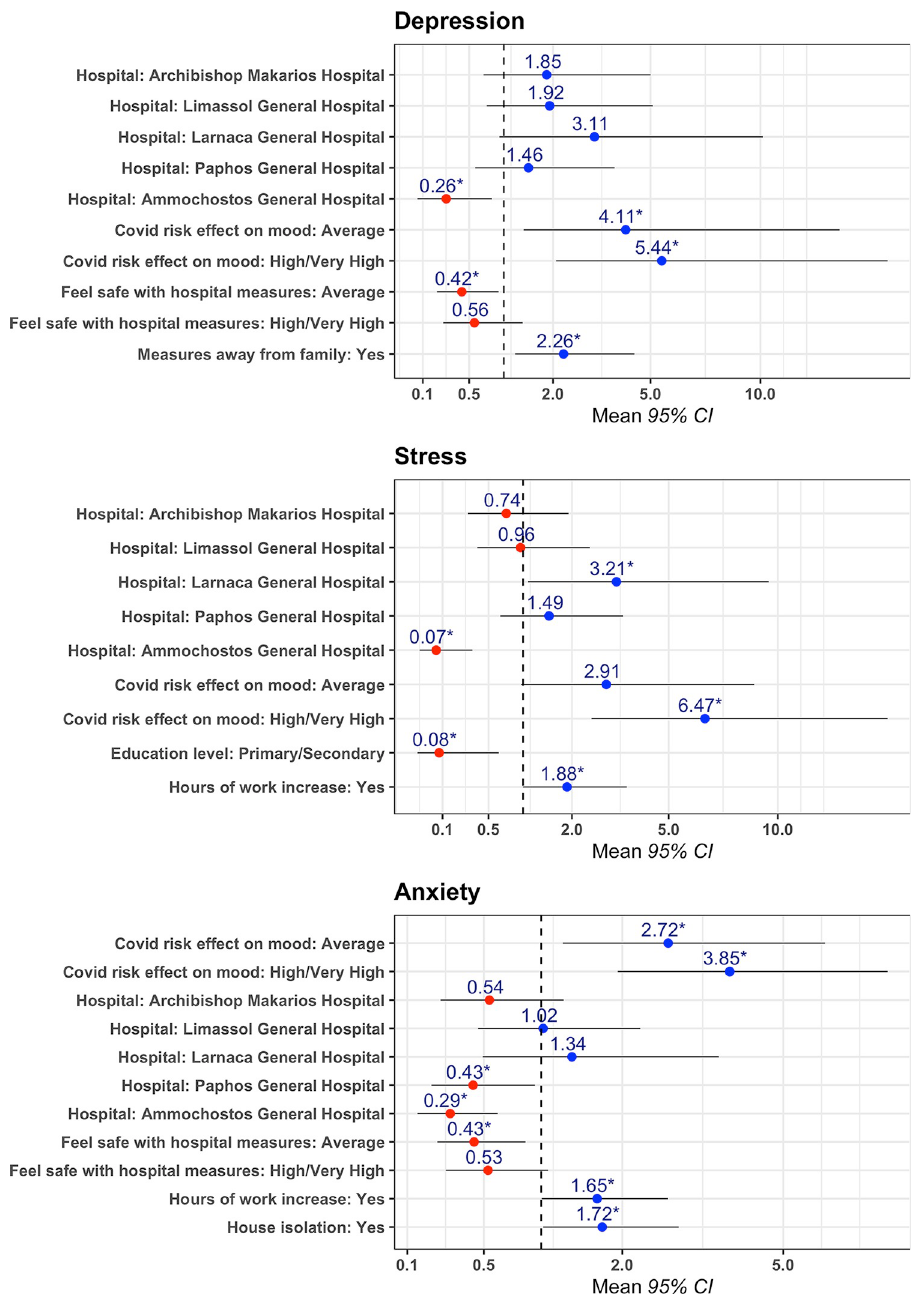
Fig 2. Multivariable logistic regression models identifying factors associated with high levels of stress, anxiety and depression.